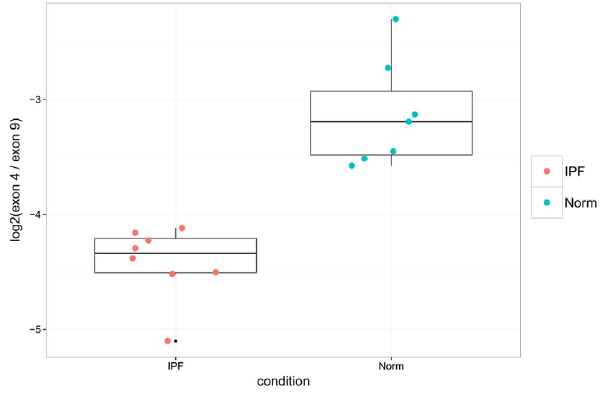
Figure 9. qPCR confirms down-regulation of COL6A3 exon 4 in IPF lung tissue. Shown are PCR ratios of COL6A3 exon usage for IPF vs controls (Wilcoxon p-value=3.108e-4).